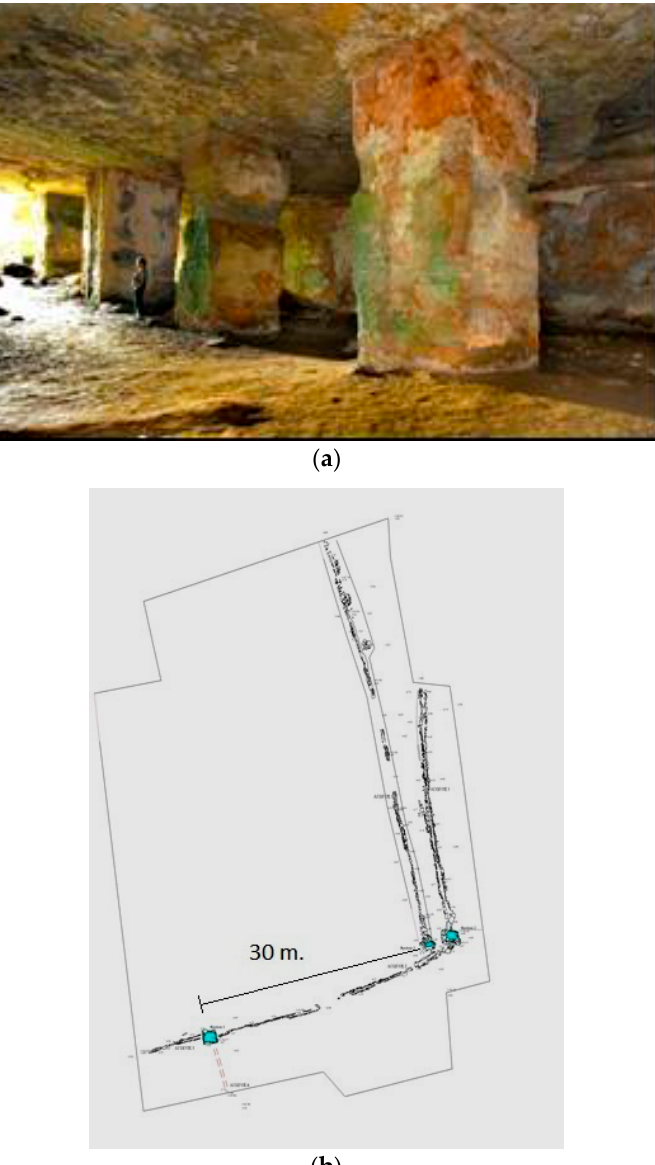
Figure 3. ( a ) View of the cistern used for water storage in Eleuthera (with permission of A. N. Angelakis); and ( b ) schematic representation of the pipes and cisterns used for storage of the water supply in the ancient Kissamos (from the files of Ephorate of Antiquities of Chania).